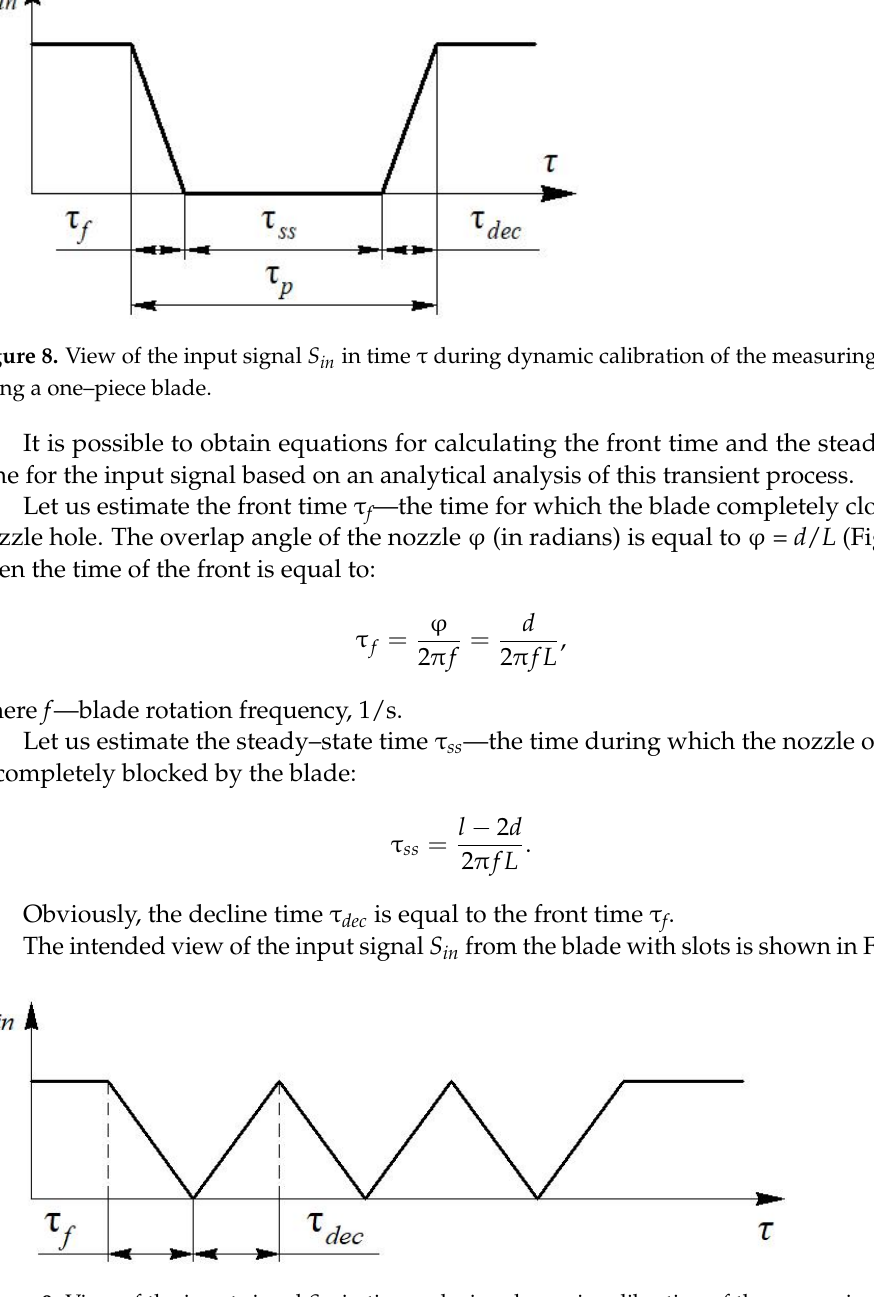
Figure 9. View of the input signal S in in time τ during dynamic calibration of the measuring system using a blade with slots. The characteristic pulsation times are τ f = τ dec = 1.7 ms, τ ss = 2 ms, τ p = 5.4 ms during rotation of a one–piece blade with parameters: L = 270 mm, l = 36 mm, d = 11.4 mm, f = 4 1/s. system) S out signals at different air flow speeds is shown in Figure